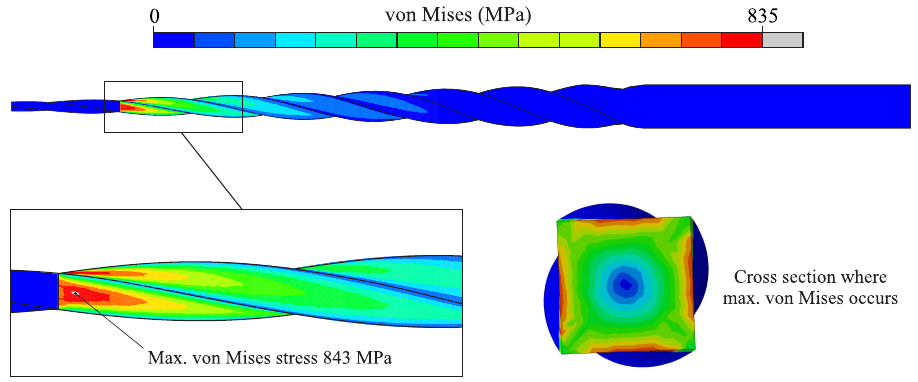
Figure 8. Stress results for torsional analysis (undeformed plot).